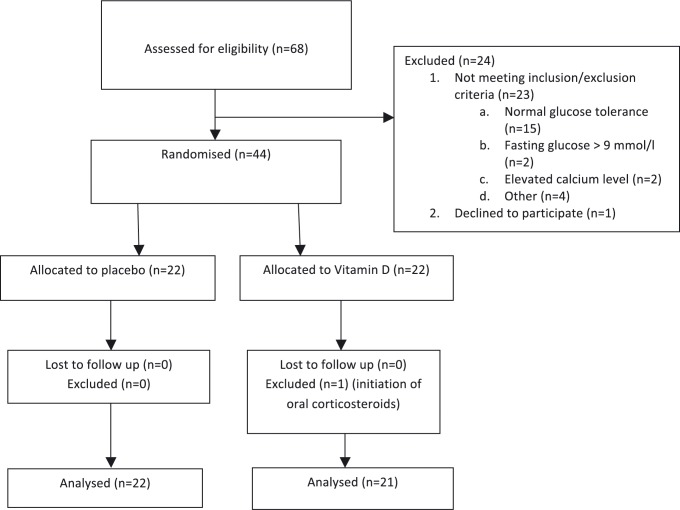
Patient flow chart.